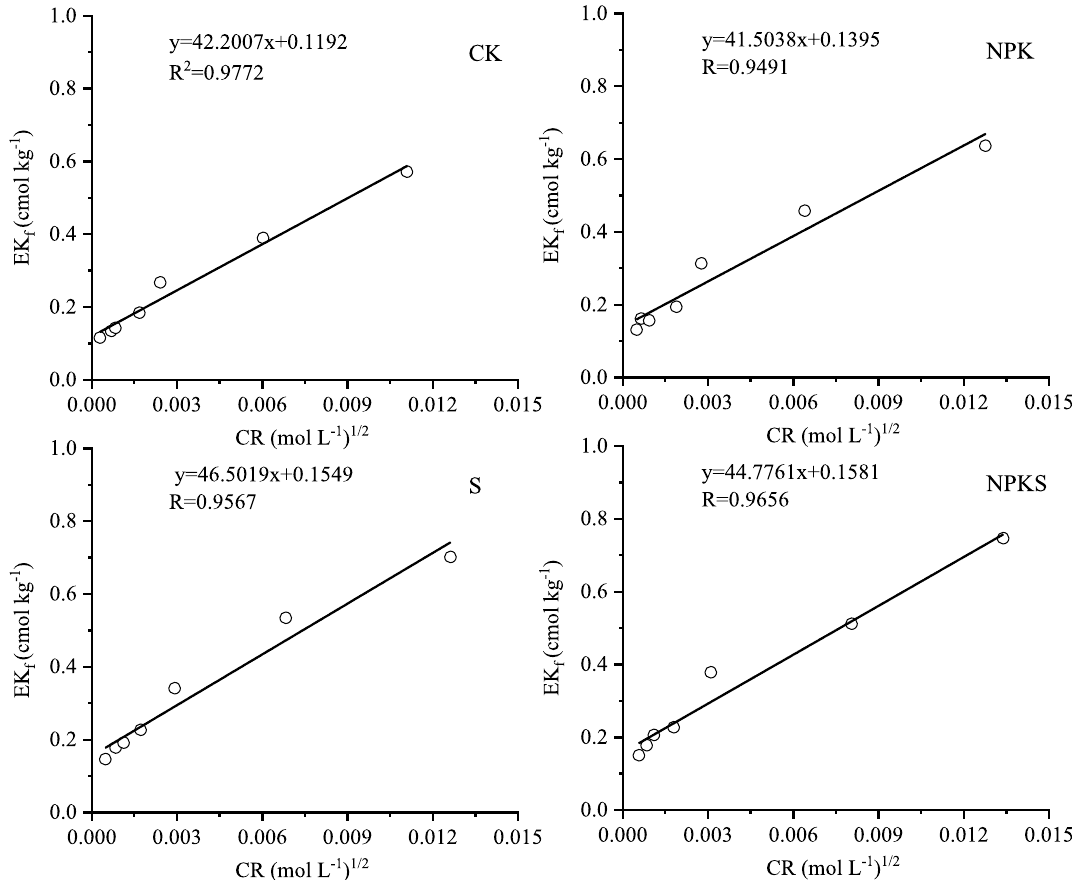
Figure 9. Plots of EK f vs. CR for tested soils with and without straw return. (CK, no fertilization; NPK, mineral fertilizing; S, straw 6000 kg h m −2 ; NPKS, NPK with straw 6000 kg h m −2 ; EK f , NH 4 OAc extractable K determined after equilibration period; CR, potassium concentration